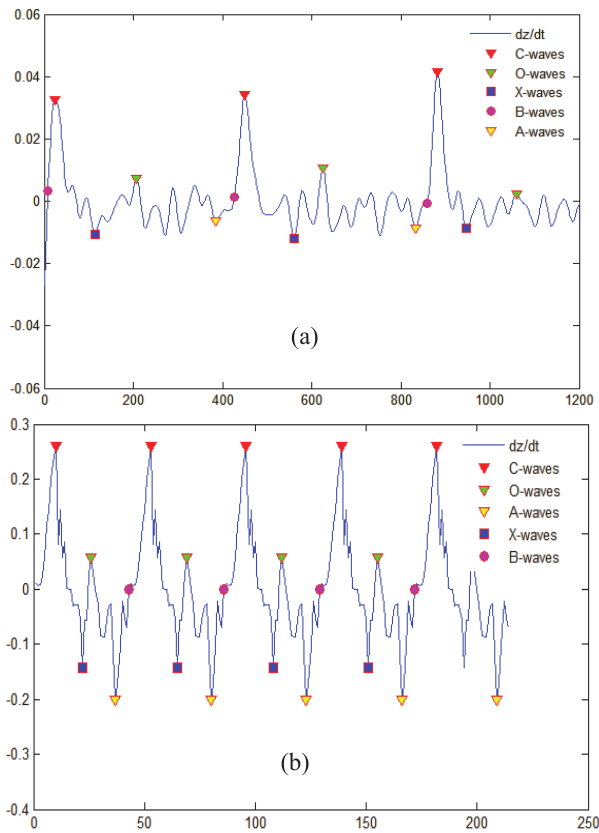
Fig.3: Impedance Cardiography traces recorded in (a) a control subject and (b) a patient with mitral insufficiency and the detection of the characteristic points (C-waves: red triangles, O- waves: green triangles, A-waves: yellow triangles, X-waves: blue squares, B-waves: pink circles).